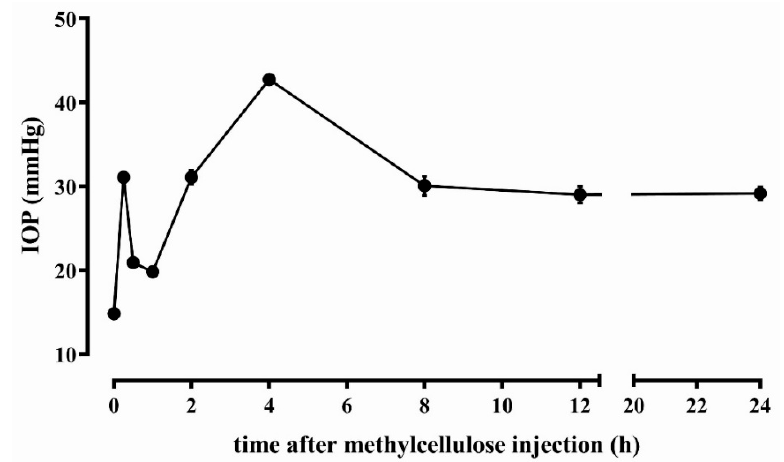
Figure 1. Time course of intraocular pressure progression in rats injected with 15 µL of 2% methylcellulose in the anterior chamber (n = 9 rats, 18 eyes).